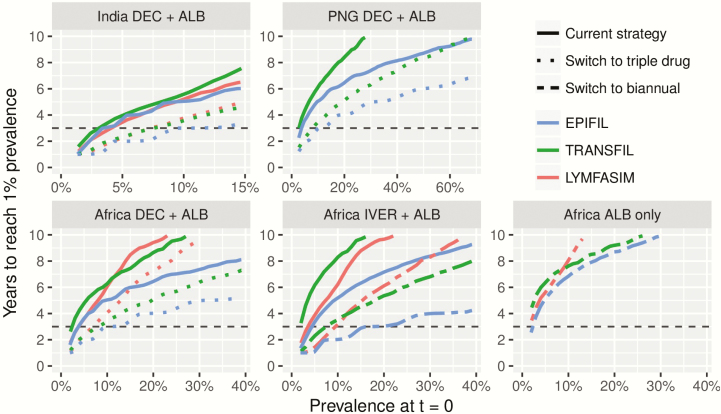
Average time needed to reach the 1% target of microfilariae (mf) prevalence in treatment-naive settings, in relation to the mf prevalence at t = 0. Each subplot represents a particular region as specified in its caption. Within each panel, results are shown for the current strategy of annual mass drug administration (MDA) with either ivermectin + albendazole (IA) or diethylcarbamazine + albendazole in comparison to ivermectin + diethylcarbamazine + albendazole (IDA; for India, Papua New Guinea, and the African DA regions) or biannual MDA (African IA region, where IDA is not recommended because of safety concerns). For Loa loa–coendemic areas, biannual MDA with albendazole alone is the recommended strategies and no alternative is shown. Horizontal line at t = 3 indicates 2020. Abbreviations: ALB, albendazole; DEC, diethylcarbamazine; IVER, ivermectin; PNG, Papua New Guinea.